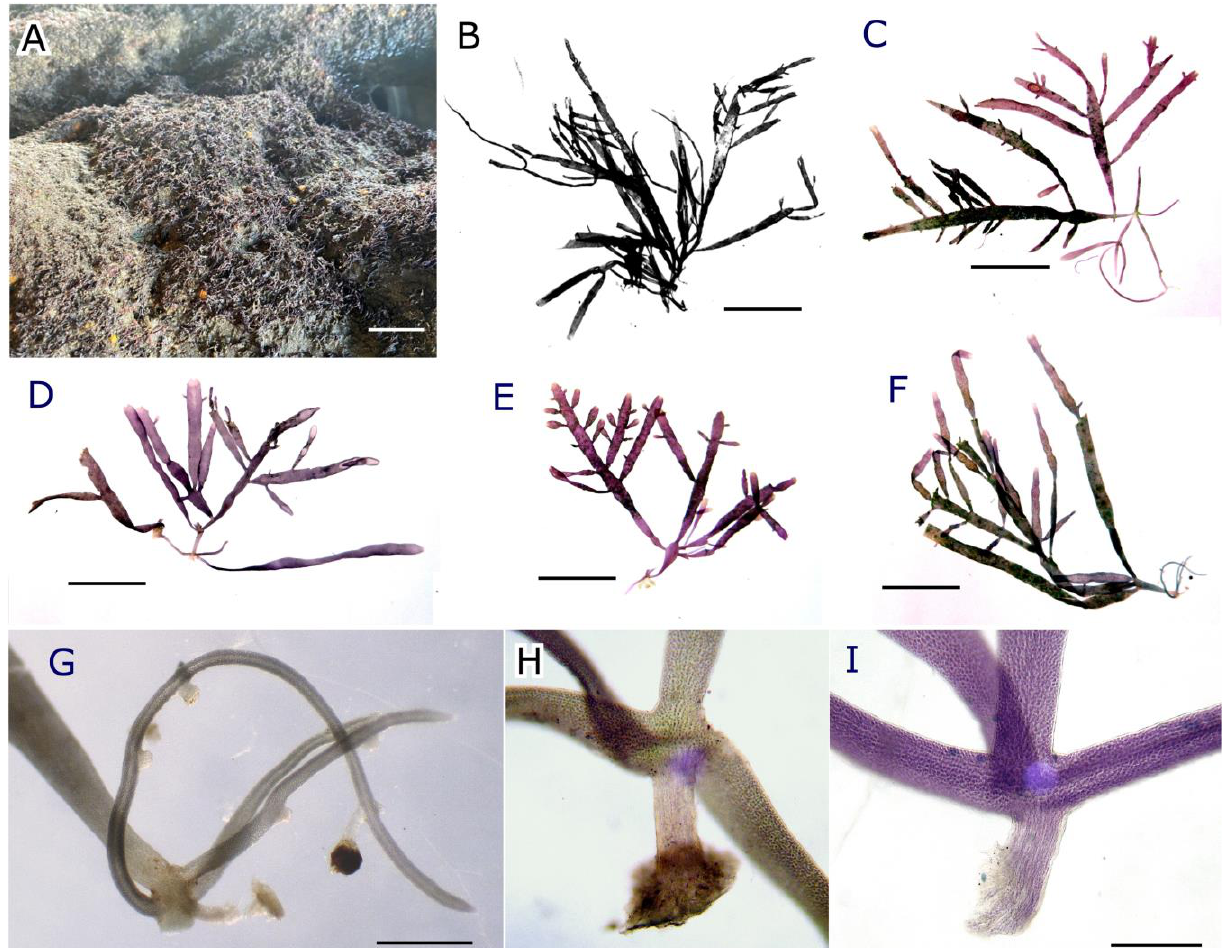
Figure 4. Pterocladiella canariensis sp. nov. ( A ) Habitat of P. canariensis , growing as turf-like tufts on rocky substrates; ( B ) holotype, preserved as a dry herbarium specimen (TFC Phyc 16400); ( C – F ) morphological variability of fresh specimens with branched erect axes arising from prostrate axes: ( C ) cystocarpic female gametophyte; ( D ) male gametophyte; ( E , F ) tetrasporophytes; ( G ) terete prostrate axes (stolon) with numerous holdfasts; ( H ) mature holdfast arising oppositely to the upright axis and ended by a small disc; ( I ) peg-like holdfast with acute end showing free rhizoidal filaments. Scale bar: 4 cm ( A ), 5 mm ( B – F ), 500 µm ( G ), and 300 µm ( H , I ).